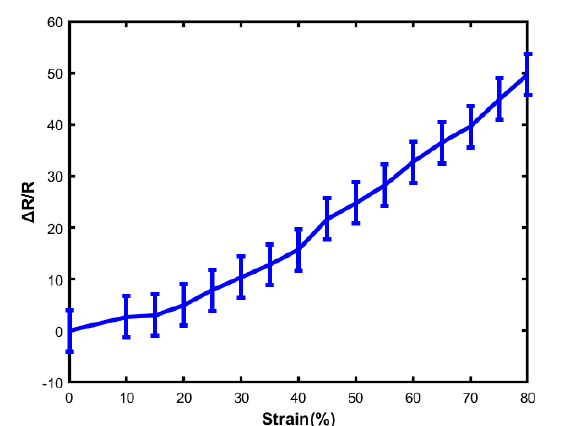
Figure 7. The relationship between strain and resistance change (pressure: 30